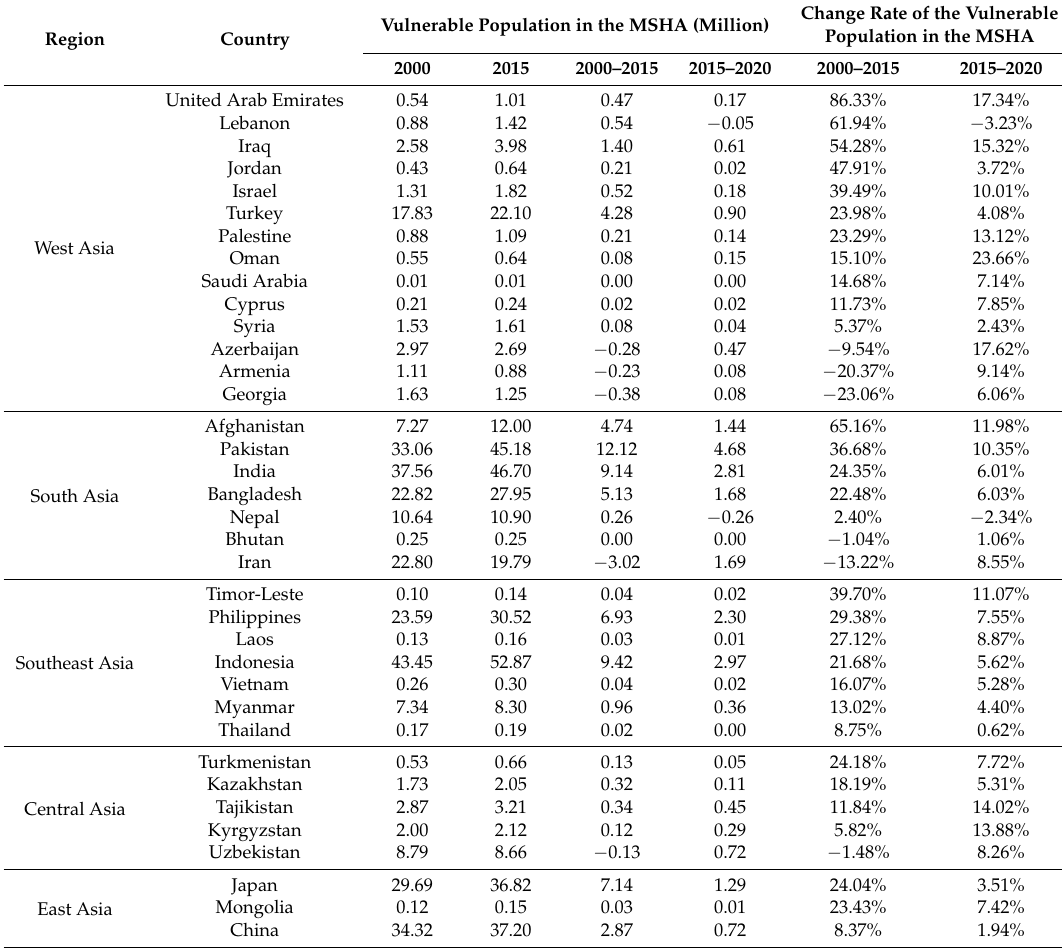
Change Rate of the Vulnerable Population in the MSHA